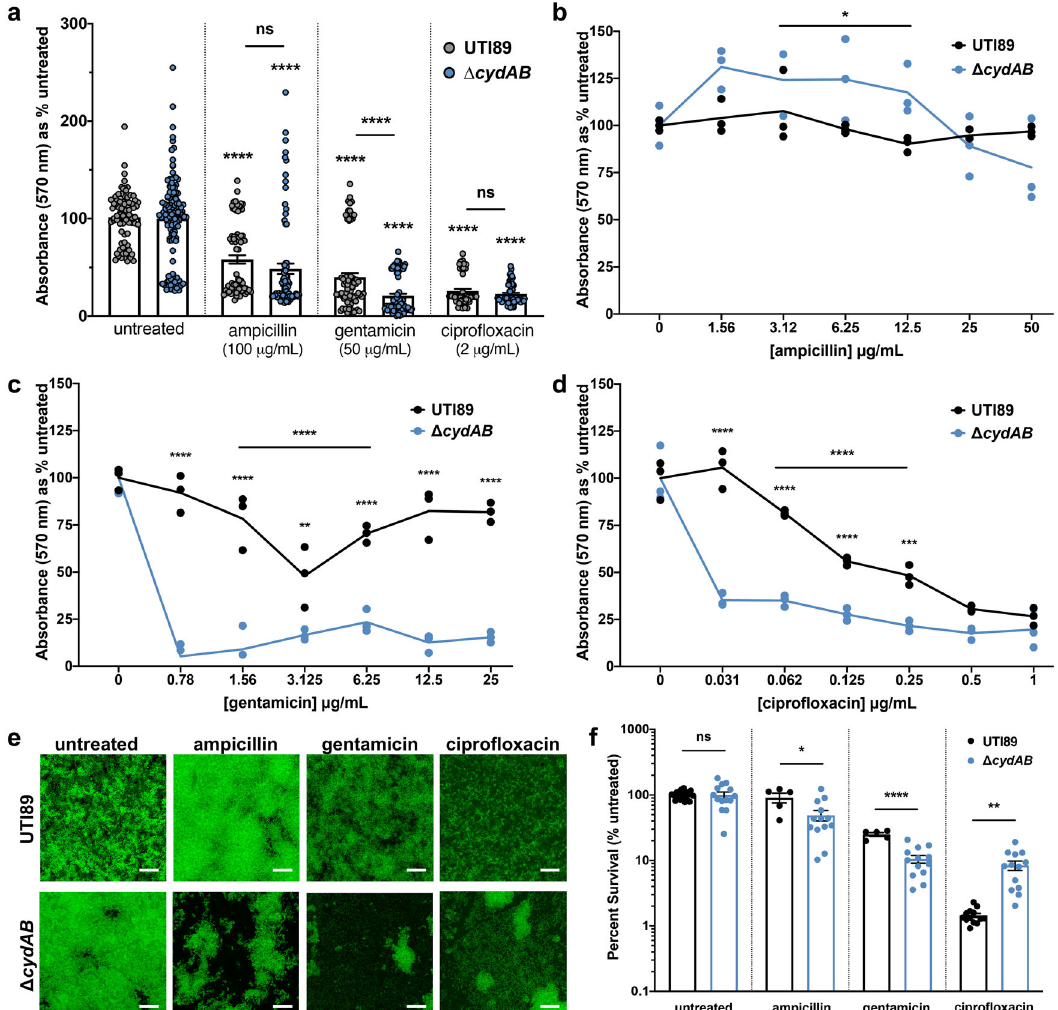
Fig. 1 Loss of cytochrome bd increases bio fi lm antibiotic sensitivity. a PVC-associated air-liquid interface bio fi lms were grown for 48 h, treated with antibiotics for 72 h, and biomass was quanti fi ed using the crystal violet assay. Bio fi lm biomass was quanti fi ed for wild-type UTI89 and isogenic cytochrome bd -de fi cient strain Δ cydAB . Data were normalized to the untreated control of each strain. The mean absorbance value in each treatment group was compared to the untreated control of the same strain (asterisks), and to the mean value of the other strain in the same treatment group (horizontal line with asterisks) using a two-tailed Welch ’ s t -test. Data represent at least three biological replicates with at least eight technical replicates each. Each dot represents an independent well. b – d Dose response curves depicting the total biomass of bio fi lms after treatment with decreasing concentrations of ampicillin ( b ), gentamicin ( c ), or cipro fl oxacin ( d ). Data were analyzed using a two-way ANOVA to evaluate overall differences between strain across the range of concentrations tested (horizontal line with asterisks), with multiple comparisons used to evaluate differences in mean at each concentration (asterisks). Data represent three biological replicates with three technical replicates each. Each dot represents the mean value of a biological replicate. Solid lines connect mean values at each concentration. e Representative images of antibiotic treated bio fi lms stained with STYO9 and imaged by confocal laser scanning microscopy. At least fi ve images were acquired along the air-liquid interface of three biological replicates. Scale bar is 20 µm. f Survival of bacteria in colony bio fi lms after antibiotic treatment. Colony bio fi lms were grown on YESCA agar for 72 h, and bio fi lms were transferred to a new plate with or without antibiotics. After 24 h of antibiotic treatment, bio fi lms were homogenized and plated to enumerate CFUs. Mean values in each treatment group were statistically compared using a two-tailed unpaired t -test. Data are representative of at least fi ve biological replicates. Each dot represents a biological replicate. For all graphs, data are presented as mean ± SEM. * p < 0.05, ** p < 0.01, *** p < 0.001, **** p <